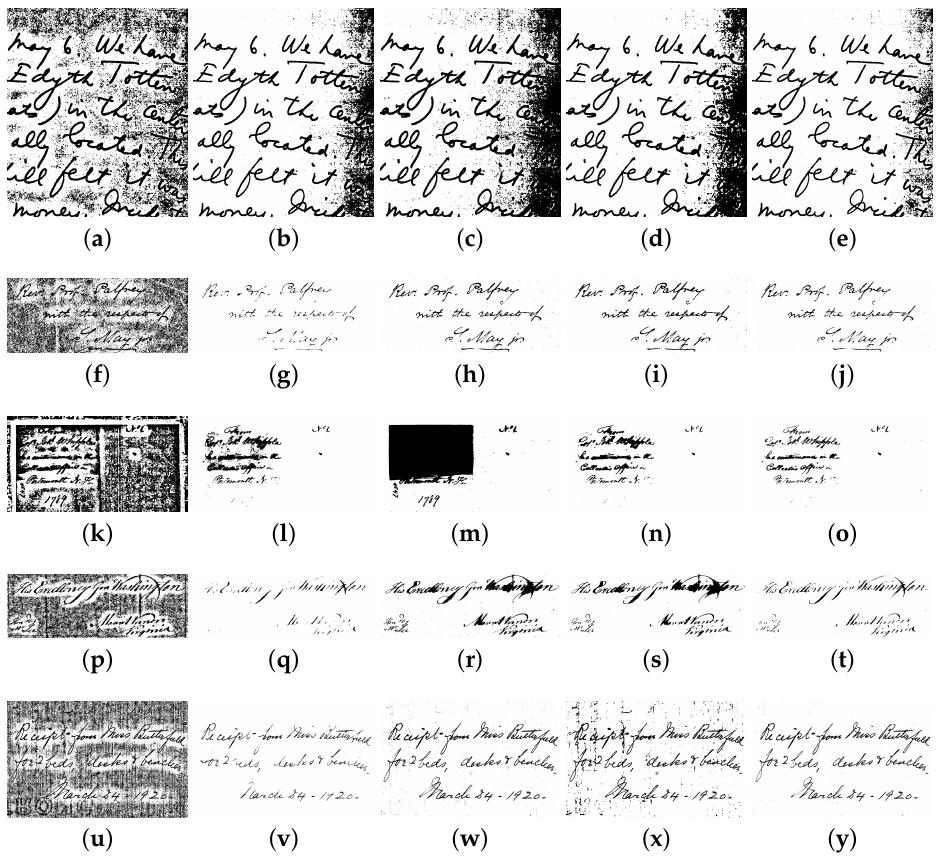
Figure 3. Results obtained by different thresholding methods: Each column from left to right shows the results of Sauvola ( a , f , k , p , u ), Grid-based Sauvola et al.’s ( b , g , l , q , v ), Grid-based Kittler et al.’s ( c , h , m , r , w ), GLGM ( d , i , n , s , x ), and Grid-based FADIT method ( e , j , o , t , y ),